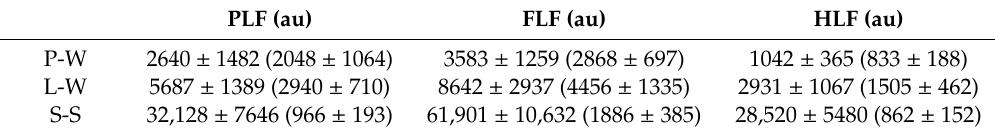
Table3. Totalandorganiccarbonstandardization(OCS)(inparentheses)fluorescentintensityofpercolation water (P-W), leachate water (L-W) and soil solution (S-S) for the EEM three regions protein- (PLF), fulvic- (FLF) and humic-like fluorescence (HLF).